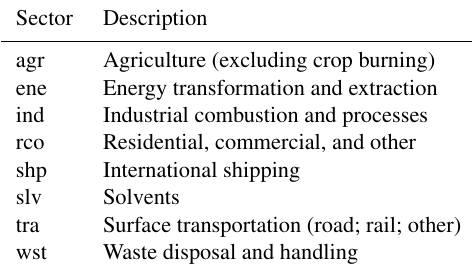
Table 2. CEDS surface emission